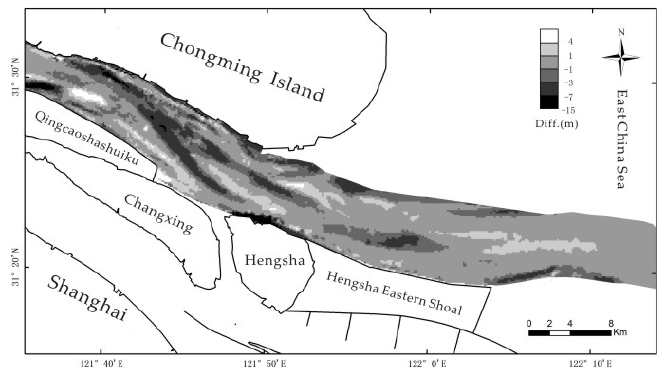
Figure 5. Thickness of deposition or erosion in the North Channel from 2007 to 2013 (negative values indicate net erosion; while positive values indicate net accretion).